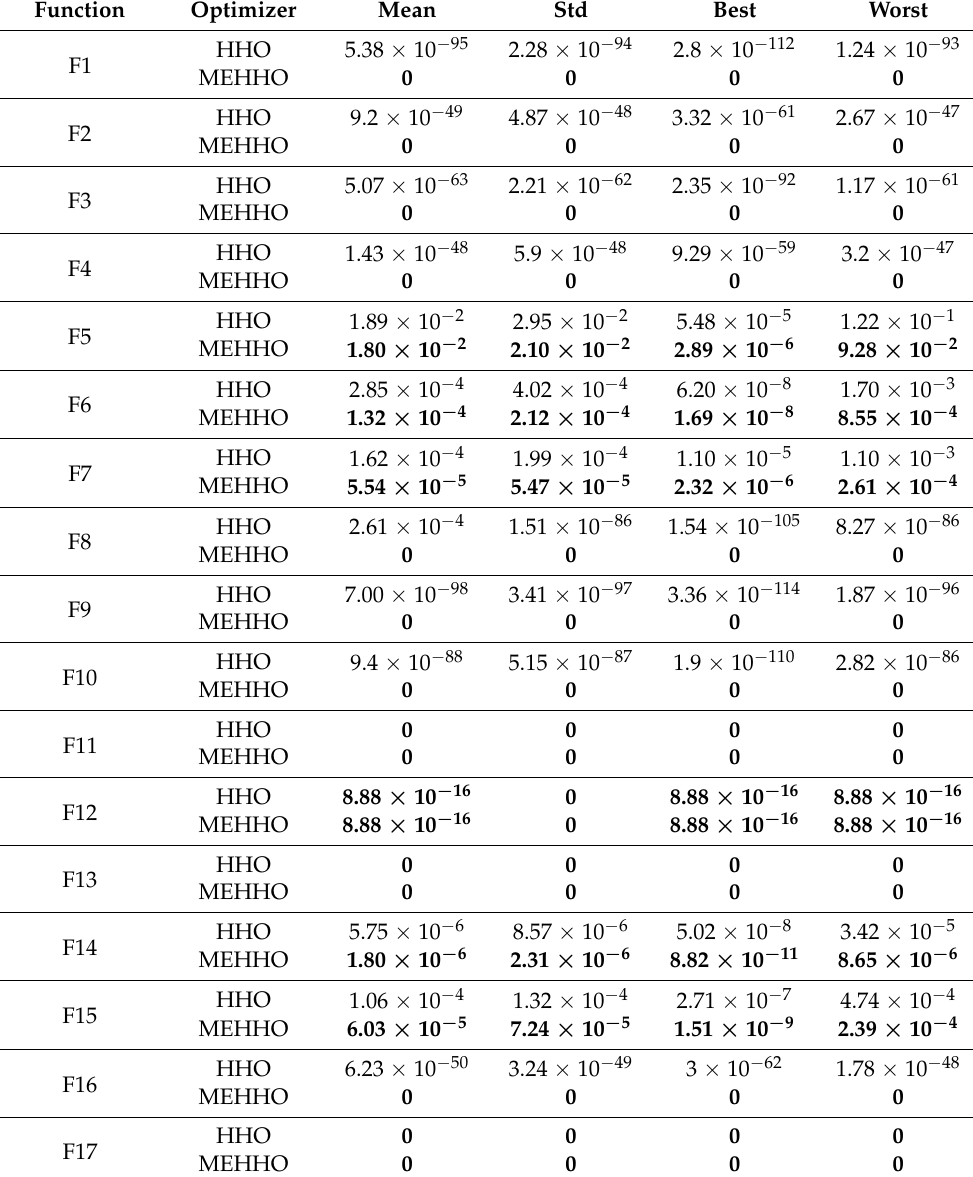
Table 7. Results comparison of variable-dimensional functions (50